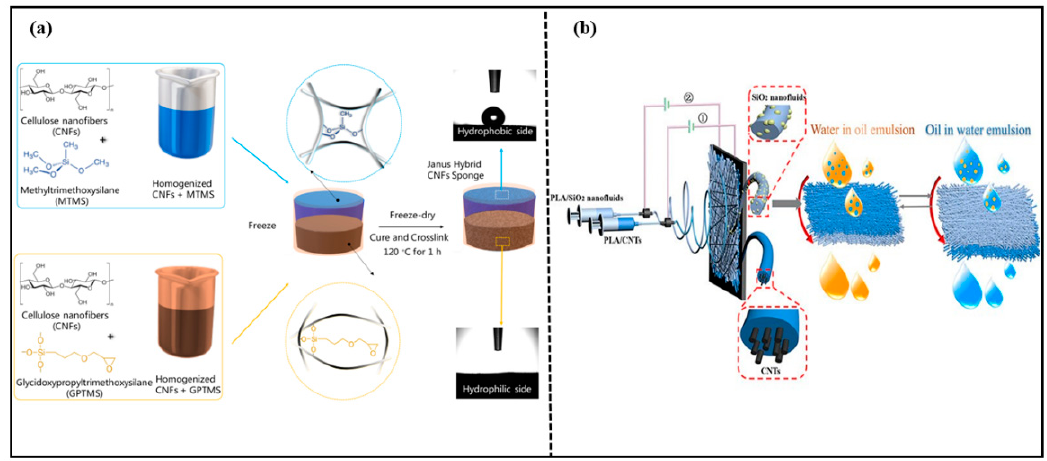
Figure 10. ( a ) Preparation of Janus hybrid sustainable all-CNF sponge. Reprint with permission from Ref. [87]. Copyright 2021, Elsevier.; ( b ) preparation route for Janus PLA hybrid fibrous membranes and the oil/water separation process. Reprint with permission from Ref. [63]. Copyright 2020, American Chemical Society.